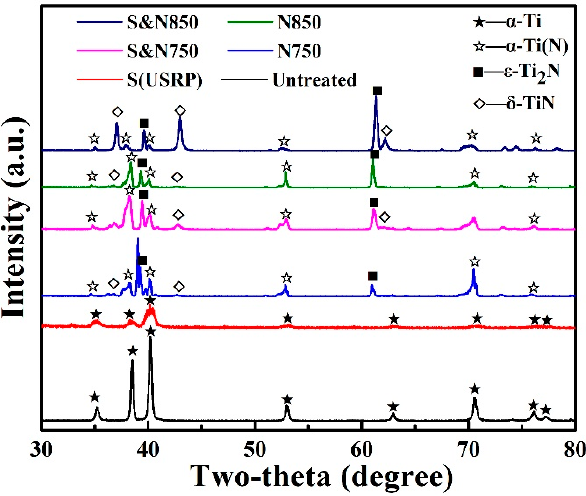
Figure 2. XRD di ff raction profiles of Ti treated by USRP pre-treatment and plasma Figure 2. XRD diffraction profiles of Ti treated by USRP pre-treatment and plasma nitriding.